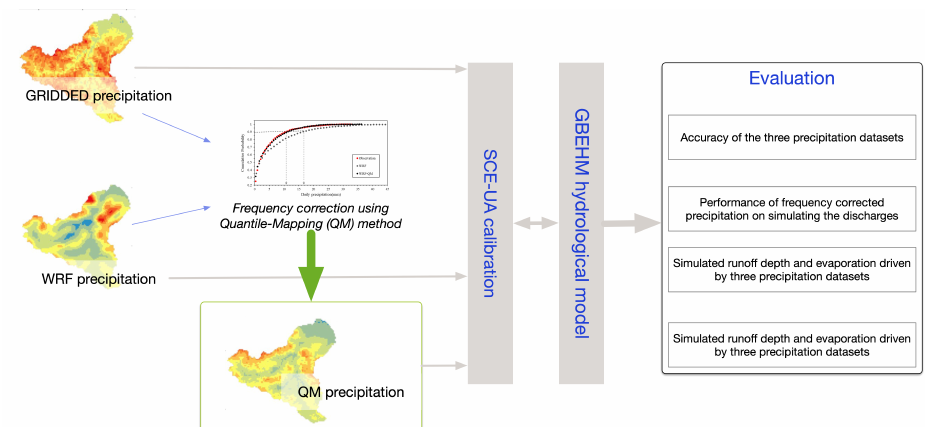
Figure 1. Flowchart of the experiments. Three precipitation datasets (the GRIDDED, WRF, and QM) were made for comparison. The QM precipitation is from the frequency-corrected WRF precipitation. The GBEHM hydrological model was used to evaluate the precipitation datasets. The SCE-UA optimization method was utilized to calibrate the hydrological model parameters for the three precipitation datasets. The hydrological simulation results driven by the three precipitation datasets were evaluated in four